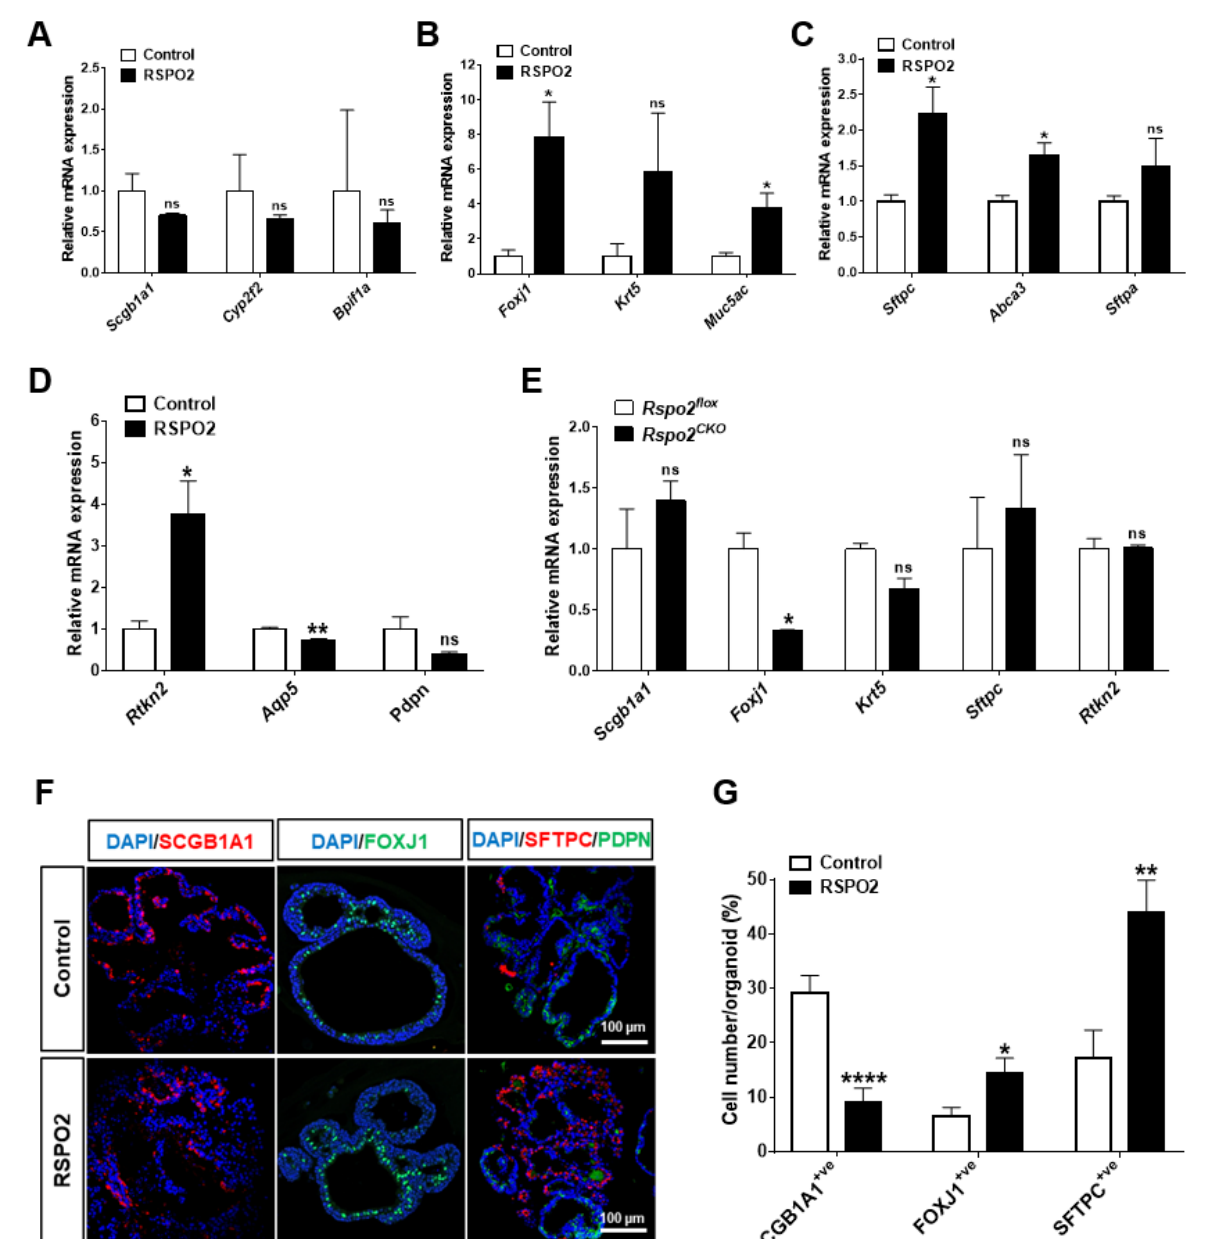
Figure 4. RSPO2 promotes the differentiation of club cells into multiple epithelial lineages in ex vivo 3D organoid culture. ( A ) qRT-PCR analysis of club cell marker genes, Scgb1a1 , Cyp2f2 and Bpifa1 , in club cell-derived organoids treated with RSPO2 (200 ng/mL) for 14 days. ( B ) qRT-PCR analysis of gene markers for ciliated ( Foxj1 ), basal ( Krt5 ), and goblet ( Muc5ac ) cells in the RSPO2 (200 ng/mL)-treated club cell-derived organoids. ( C , D ) qRT-PCR analysis of AT2 cell marker genes ( C ) Sftpc , Abca3 , and Sftpa , and AT1 cell marker genes ( D ) Rtkn2 , Aqp5 , and Pdpn in the RSPO2-treated club cell-derived organoids. ( E ) qRT-PCR analysis of various differentiated cell marker genes in Rspo2 CKO club cell-derived organoids. ( F , G ) Immunofluorescence staining images for SCGB1A1, FOXJ1, SFTPC, and PDPN, and quantification of SCGB1A1 +ve club, FOXJ1 +ve ciliated, and SFTPC +ve AT2 cells in the RSPO2 (200 ng/ml)-treated club cell organoids. All organoids were collected after 14 days in culture. Data are presented as mean ± SEM. ns: no statistical significance, * p < 0.05, ** p < 0.01, **** p